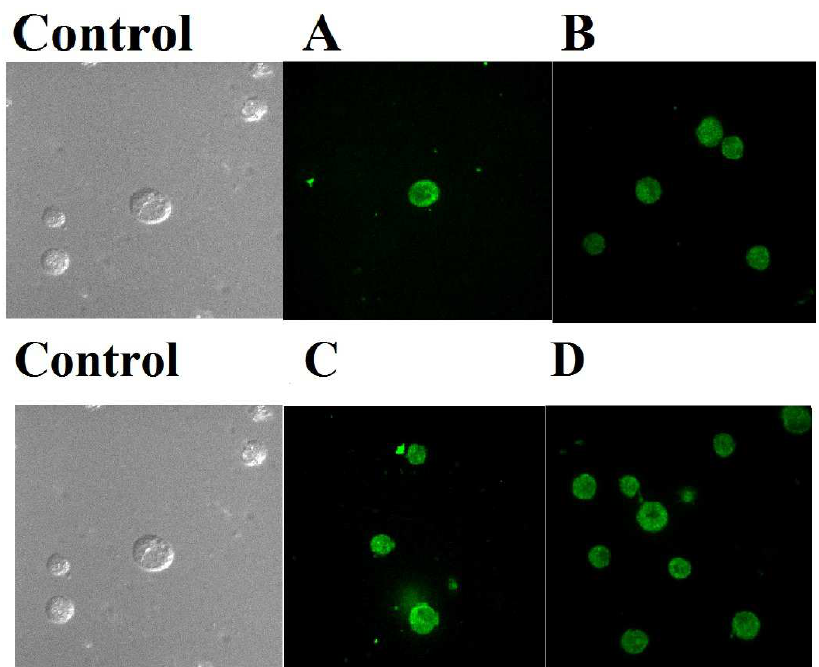
Figure 9. ( A ) Antibody conjugated nanoliposome formulation at concentration 50 μg/mL for 1 h. ( B ) Antibody conjugated nanoliposome formulation at concentration 100 μg/mL for 1 h. ( C ) Anti- ( B ) Antibody conjugated nanoliposome formulation at concentration 100 µ g/mL for 1 h. ( C ) Antibody body conjugated nanoliposome formulation at concentration 50 μg/mL for 2 h. ( D ) Antibody con- conjugated nanoliposome formulation at concentration 50 µ g/mL for 2 h. ( D ) Antibody conjugated jugated nanoliposome formulation at concentration 100 μg/mL for 2 h. nanoliposome formulation at concentration 100 µ g/mL for 2